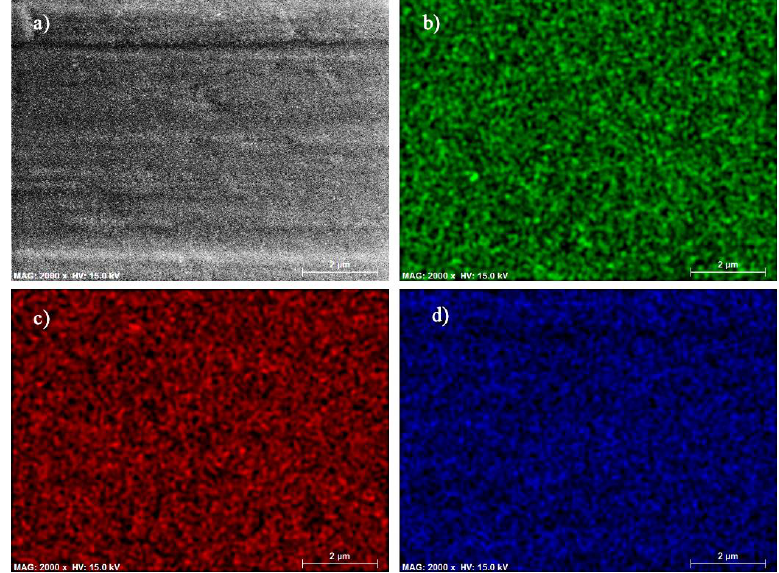
Figure 2. EDS mapping images of SDC 20 thin films deposited on 50 °C temperature substrates using a 1.6 nm/s deposition rate: ( a ) topographic image, ( b ) Samarium (Sm Lα), ( c ) Cerium (Ce Lα), ( d ) Oxygen (O Kα).